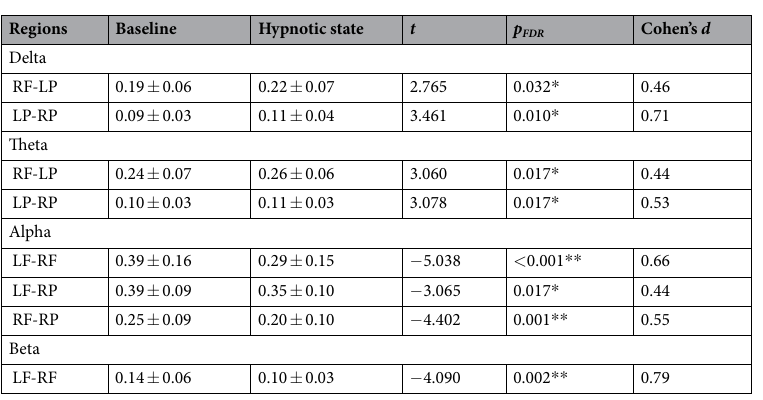
Table 2. EEG coherence in five difference frequency bands (hypnotic state > baseline). Note: * p < 0.05, ** p <